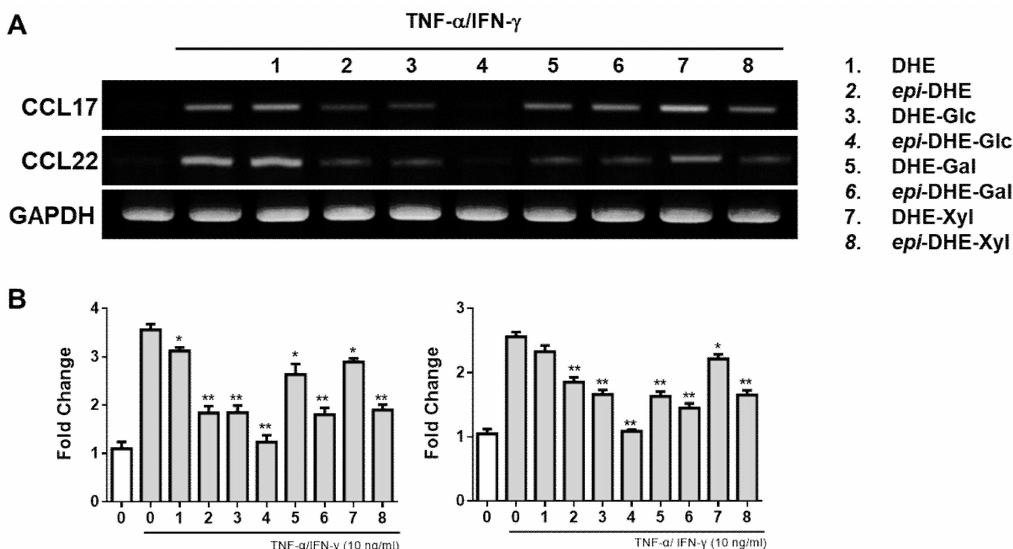
Figure 1. E ff ects of epimers of DHE on CCL17 and CCL22 mRNA expression. CCL17 and CCL22 mRNA levels were determined using an RT-PCR assay ( A ). mRNA expression levels of the chemokines CCL17 (left) and CCL22 (right) were normalized to GAPDH by quantitative real-time-PCR ( B ). All experiments were performed in triplicate and repeated at least three times. * p < 0.05 compared to treatment with positive control, ** p < 0.01 compared to treatment with positive control.